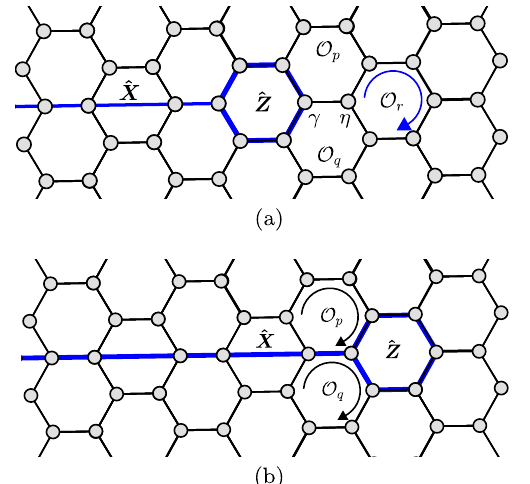
ˆ X ˆ Z and ˆ Z ˆ Z in the next ˆ O ˆ O and to six-Majorana p q